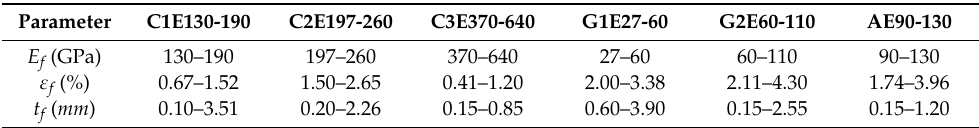
Table 3. Fiber material properties for different segments of the fiber-reinforced polymer (FRP)-confined concrete database.